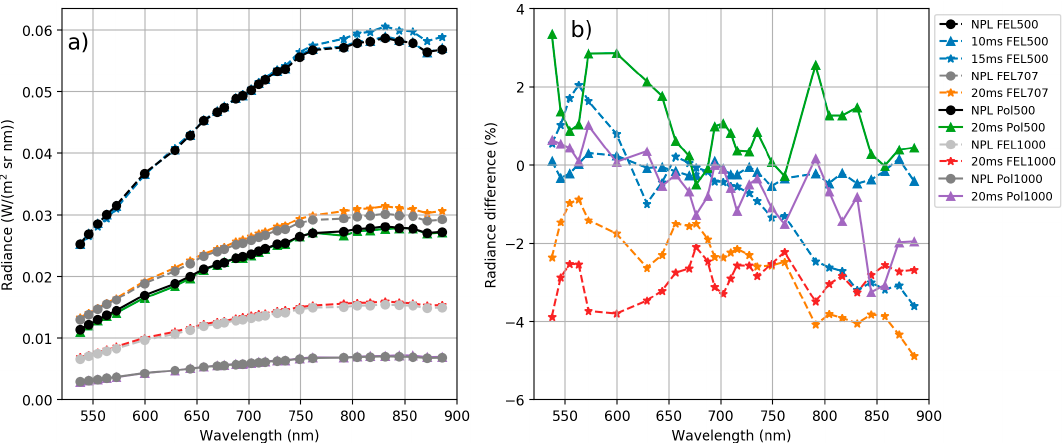
Figure 13. New adjusted radiance spectra L New ( a ) and percentage difference to NPL reference L NPL_ref